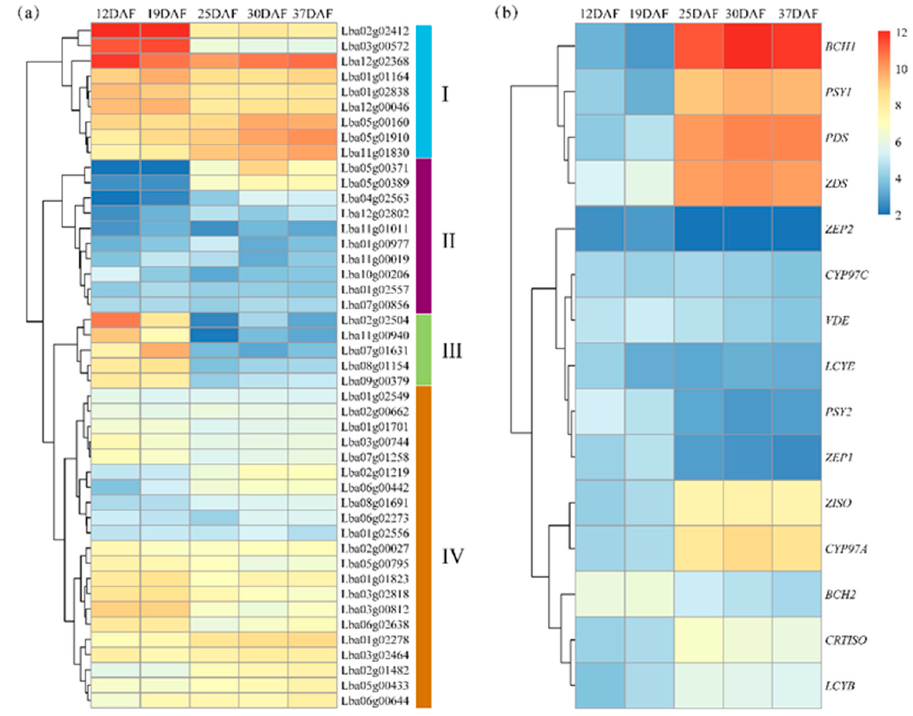
Figure 7. A heatmap of LbaR2R3-MYB DEGs and CBGs in wolfberry. Expression profiles using RNA-seq Fragments Per Kilobase Million (FPKM) data in fruit development between 12 DAP and 37 DAP. ( a ) LbaR2R3-MYB DEGs expression level. ( b ) CBGs, including PSY: phytoene synthase; PDS : phytoene desaturase; ZDS : ζ -carotene desaturase; ZISO : 15-cis- ζ -carotene isomerase; CRTISO : carotenoid isomerase; LCYB : lycopene β -cyclase; LCYE : lycopene ε -cyclase; BCH : β -carotene hy- droxylase; CYP97A : cytochrome P450-type β -hydroxylase; CYP97C : cytochrome P450-type monoox- ygenase; ZEP : zeaxanthin epoxidase; and VDE : violaxanthin de-epoxidase. Log2 (FPKM +1) values were displayed according to the color code (Top right). The red and blue colors represent the highest and lowest expression levels, respectively. 2.7. Co-Expression Analysis of Carotenoid-Biosynthetic Gene and LbaR2R3-MYBs A co-expression network of carotenoid biosynthetic genes was constructed to inves- tigate the potential of LbaR2R3-MYB TFs for regulating carotenoid biosynthesis in wolf- berry (Figure 8). First, the expression levels of 45 LbaR2R3-MYB DEGs and 15 CBGs were used to calculate Pearson’s correlation coefficients (PCCs). Gene pairs with |PCCs| < 0.80 and p ＞ 0.05 were removed, and the remaining gene pairs were used to construct the co- expression network. From the network, 15 CBGs, 32 LbaR2R3-MYB TFs, and 230 pairs were constructed a co-expression relationship (Table S9 and Figure S6). Several LbaR2R3- MYB TFs (8, 9, 8, 9, and 7) had a highly positive correlation with PSY1 , BCH1 , ZDS , PDS , and ZISO genes, respectively, whereas some of LbaR2R3-MYB TFs (11, 8, 12, 11, 13) had a highly negative with PSY1 , BCH1 , ZDS , PDS , and ZISO genes, respectively. These TFs might regulate the expression of five important genes for accumulating carotenoids. For example, gene BCH1 positively correlated with nine TFs and negatively correlated with eight TFs. The coefficients of eight positively correlated TFs were > 0.900, while eight neg- atively correlated TFs were < − 0.900 (Table S9).